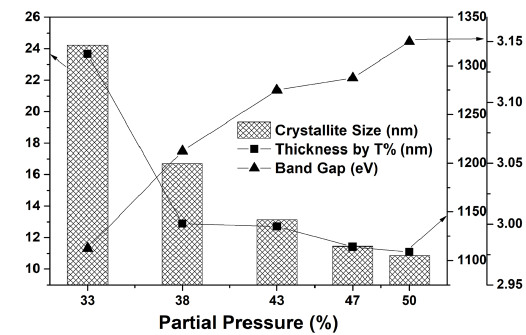
Figure 6. Thickness, Crystallite Size, and Band gap energy of AZO coatings prepared at different argon partial pressures.